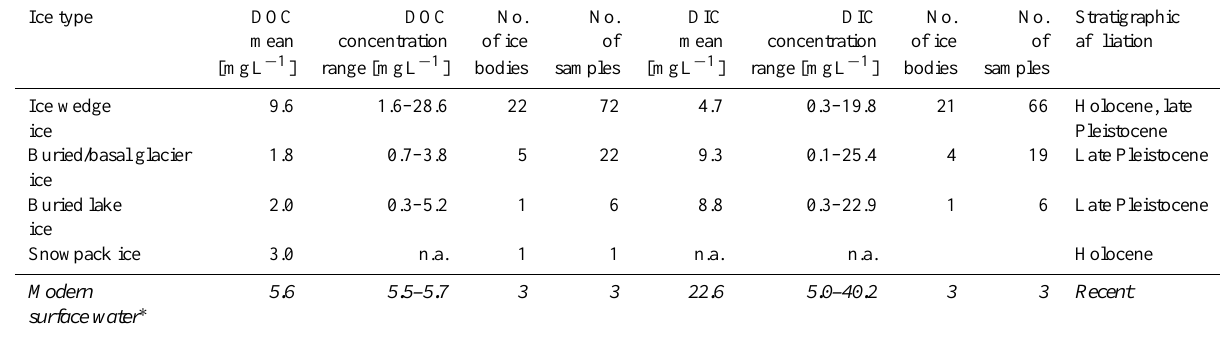
Table 2. Summarized DOC and DIC concentrations of different massive ground-ice types. For individual sample values see Table S1. Ice